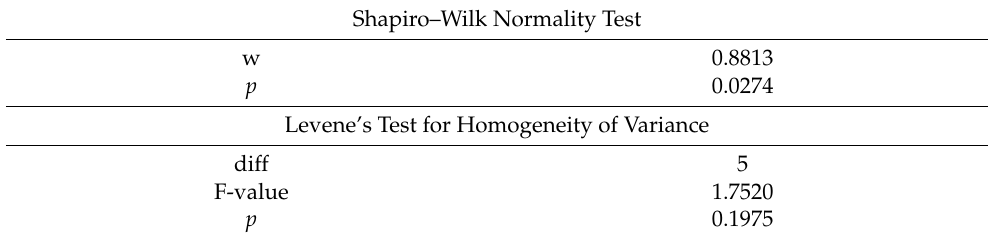
Table 10. Shapiro and Levene’s test result (KTD).